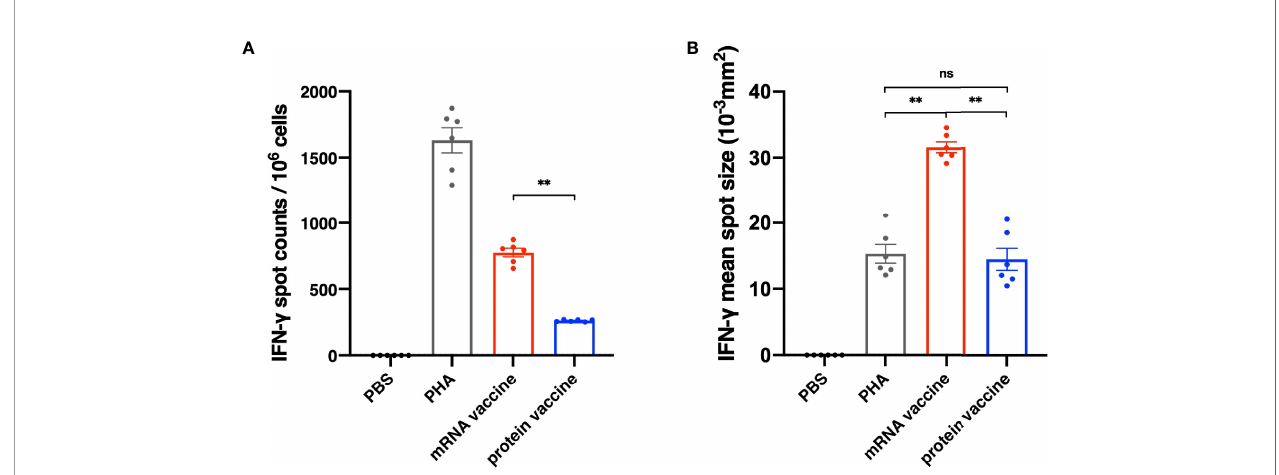
FIGURE 4 | Cellular Immune Response results of different vaccines. (A) The number of IFN- g spot counts per 10 6 splenocytes. (B) IFN- g mean spot size of different vaccine groups. The data are presented as mean± SEM from six mice in each group. PBS was included as the control. Signi fi cance was calculated using unpaired t test (ns, not signi fi cant; *p < 0.05, **p < 0.01, ***p < 0.001, ****p <